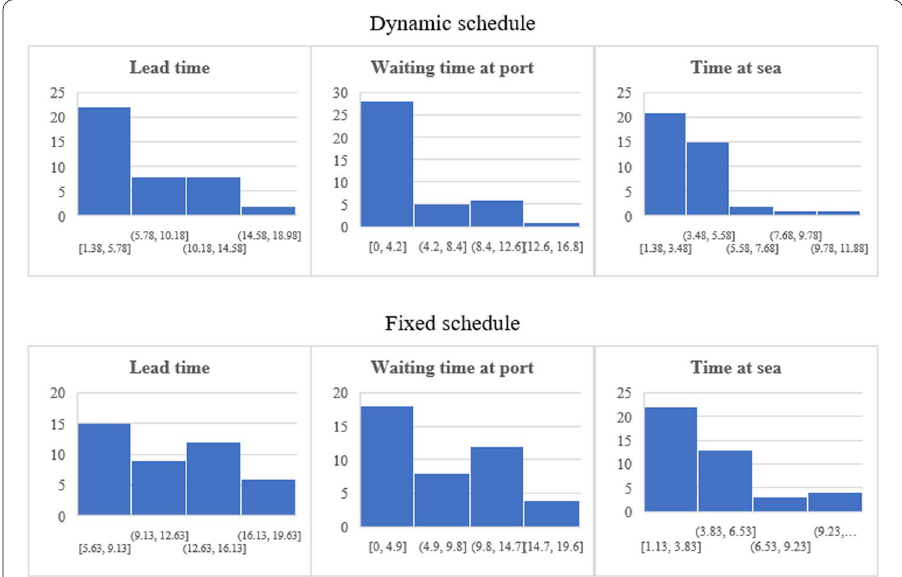
Fig. 4 Distribution of lead time, waiting time, and time at sea for the dynamic and fixed schedules (in